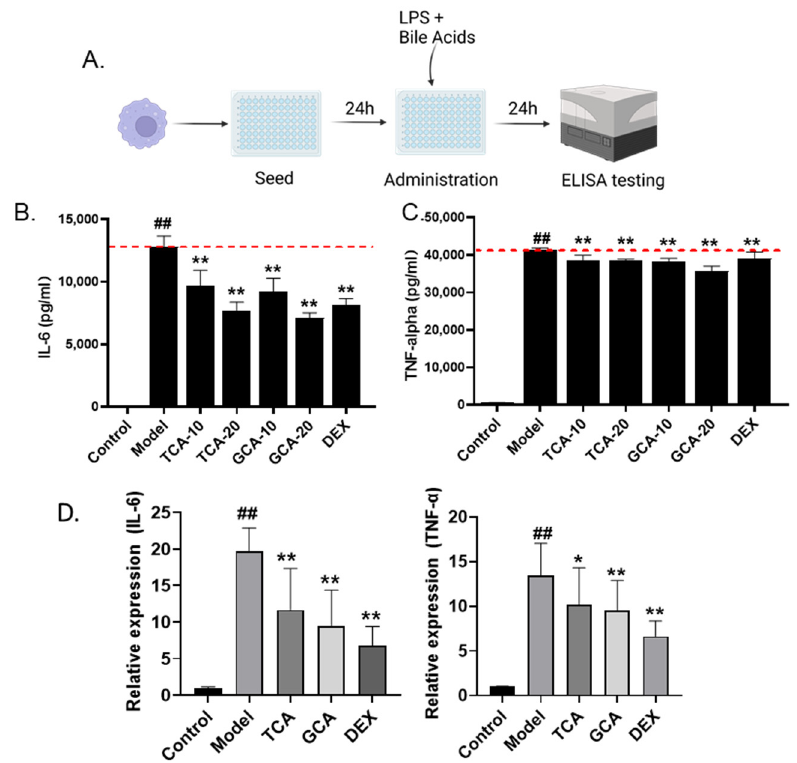
Figure 5. Validation of TCA and GCA in LPS-stimulated macrophages. ( A ) Flow chart of LPS-induced macrophage cell modeling. ( B , C ) The effect of TCA and GCA on the secretion of IL-6 and TNF- α in LPS-stimulated RAW264.7 cells. Each bile acid was tested at two concentrations of 10 and 20 µ g/mL. DEX (8 µ g/mL) is used as positive control. ( D ) Expression of inflammatory cytokines in TCA and GCA treated macrophages. All the data are presented as the mean ± SEM of three independent experiments. # Compared with the control group; *compared with the model group; *, p < 0.05, ## or **, p < 0.01.